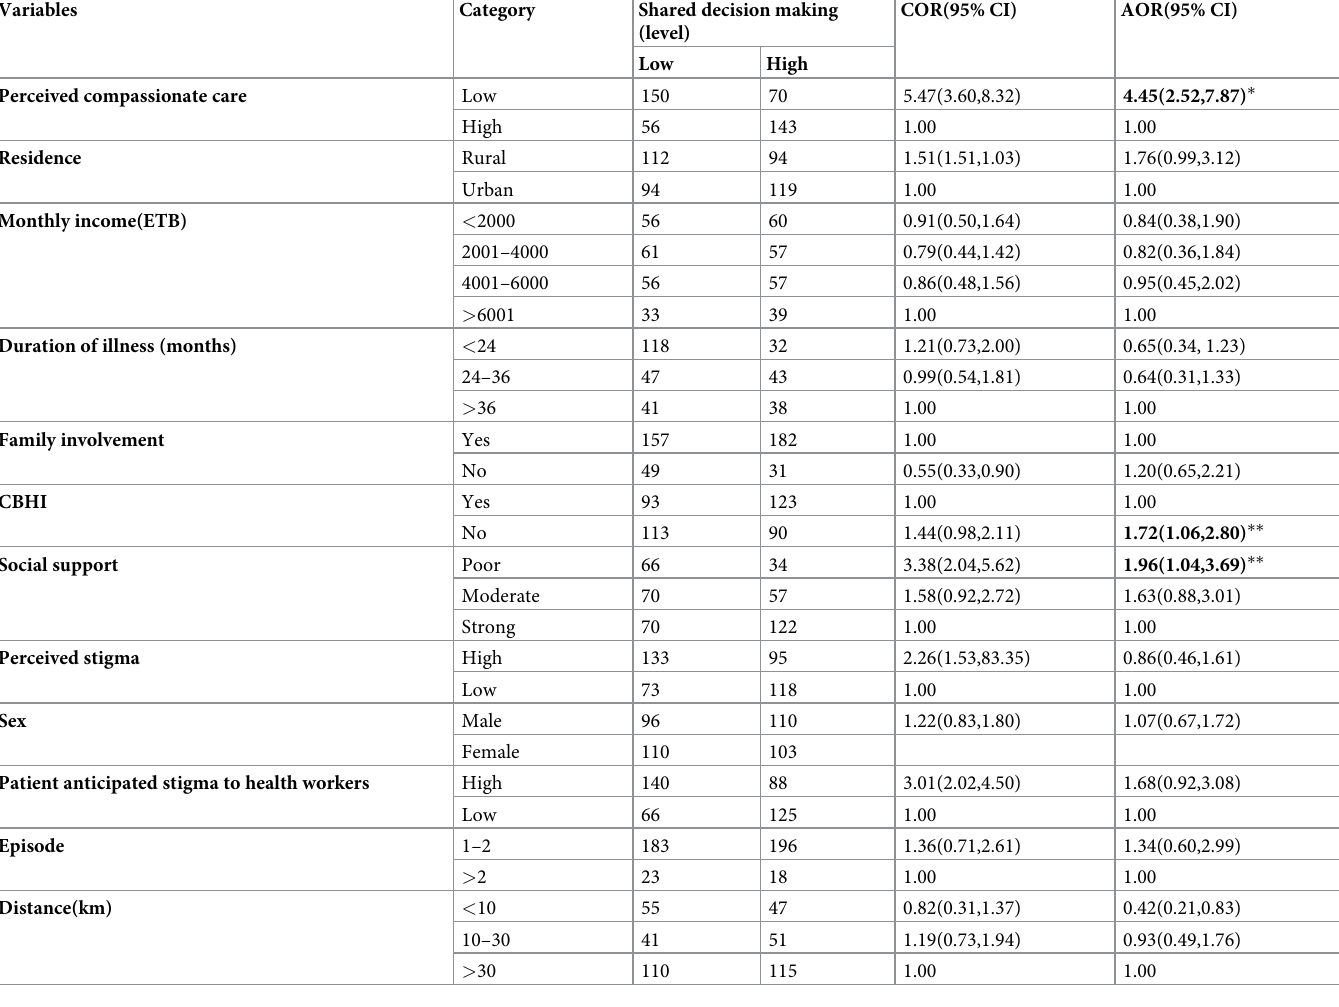
Table 3. Bi-variable and multivariable binary logistic regression analysis showing the association between shared decision-making involvement and associated fac- tors among patients with mental illness at TGSH and FHCSH (n =